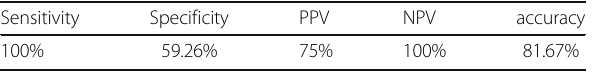
Table 8 Sensitivity, Specificity, PPV, NPV, and accuracy of P300 in the detection of neurocognitive impairment in HCV group